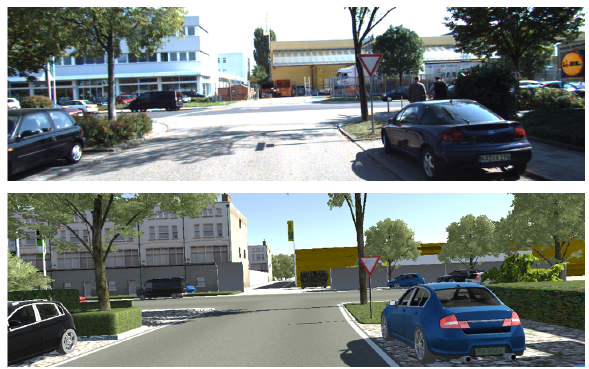
Figure 4. Synthetic images (bottom) in the vKITTI dataset are based on real images (top) in the KITTI dataset. Objects like buildings, vegetation, streets and cars, can be identified in both the virtual and real scene based on their placement, but the geometry and material of the virtual object seem to be simplified.